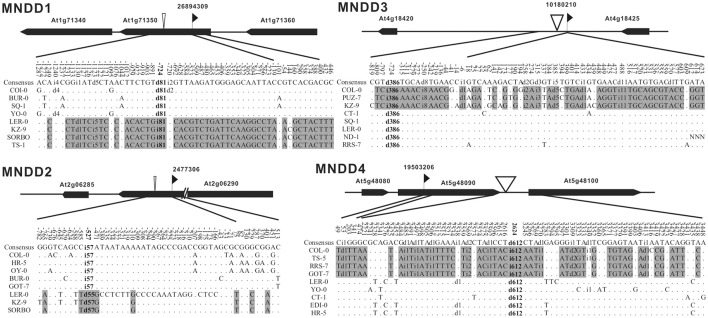
Polymorphism around the selected dimorphic locus MND1–4. The number represents the position relative to the first base pair of the sequenced regions in the Nordborg dataset (indicated by the flag). The extensions of the original dimorphic SNPs are marked by gray. The positions of identified indels are indicated by open triangles.